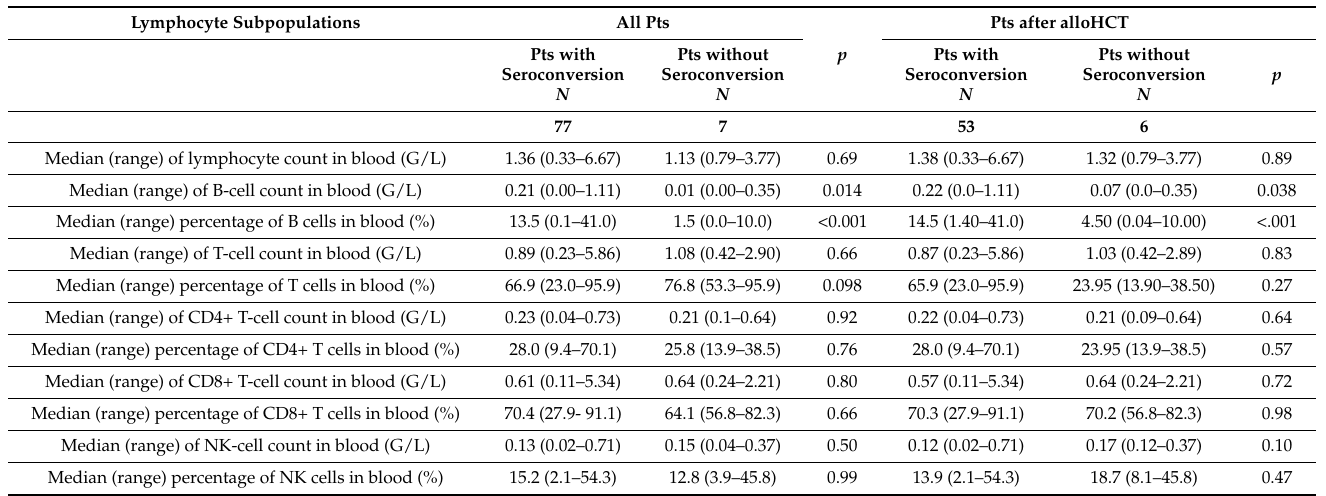
Table 5. Lymphocyte subpopulations in peripheral blood at SARS-CoV-2 vaccination by serological conversion after